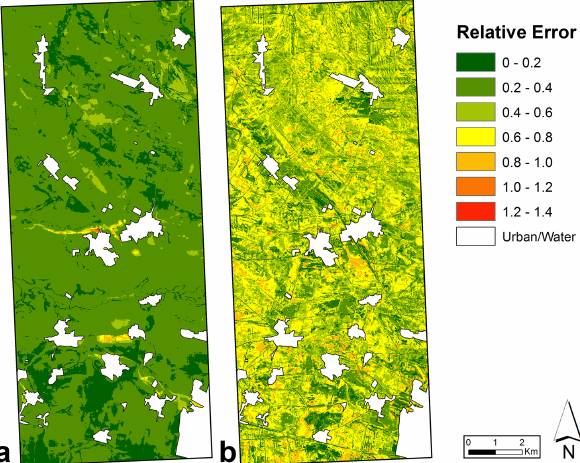
Figure 6. Estimated relative error for the total SOC stock modelled by (a) the direct approach and (b) the indirect